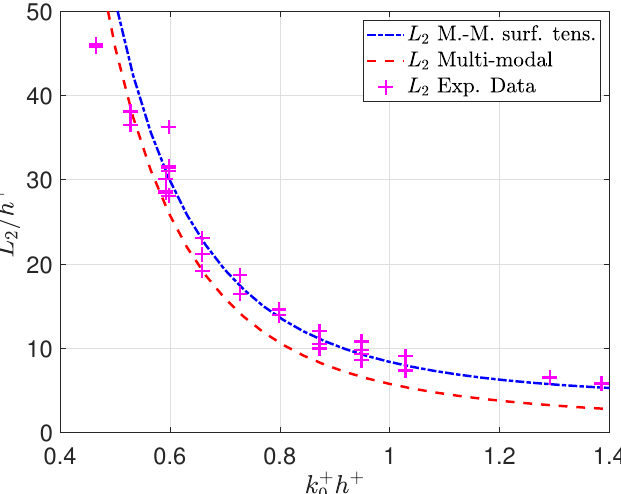
Figure 17. Beating length of the second harmonic η 2 as a function of the non-dimensional wavenum- ber k + h + . Two theoretical curves of L 2 are calculated from Equation (72): First, the blue dash-dotted 0 line shows L 2 calculated with wavenumbers from Equation (71), and second, the red dashed line shows L 2 with wavenumbers from Equation